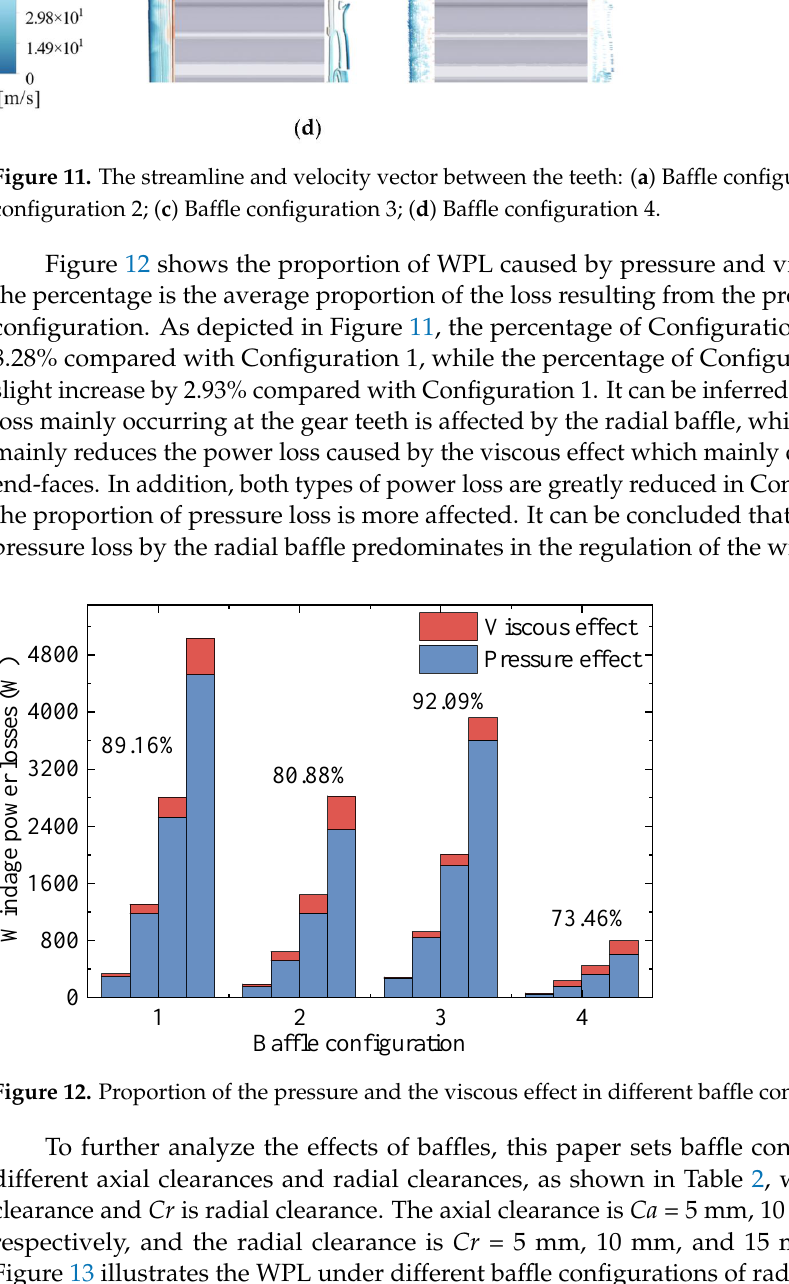
Figure 12. Proportion of the pressure and the viscous effect in different baffle configurations.